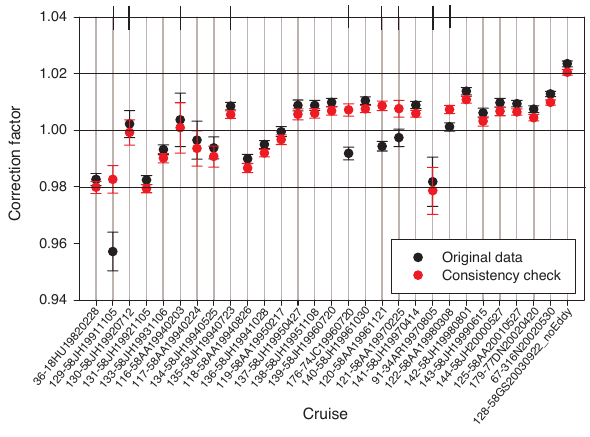
Figure 3. Oxygen corrections (multiplicative) and their uncertain- ties (vertical bars) determined through the WLSQ inversion of the crossover o ff sets from data with and without corrections applied. 58GS20030922 (128) had several stations in a submesoscale co- herent eddy (Kasajima et al., 2006), the “ noEddy” signifies that these data were removed prior to this analysis. Note that the cruises have been sorted by time in this figure. The crossover re- sults that were used in the inversions to prepare this figure can be accessed at the CARINA website (http: // cdiac.ornl.gov / oceans / CARINA / Carina inv.html). The vertical lines through the upper x- axis indicates the cruises that were singled out for adjustment con-